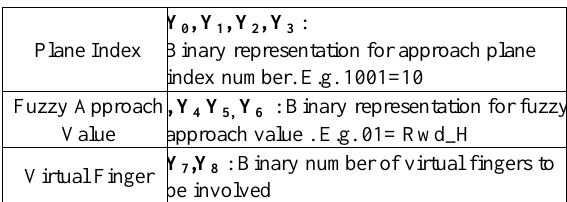
Table 3 Ouput Vector of ANN.